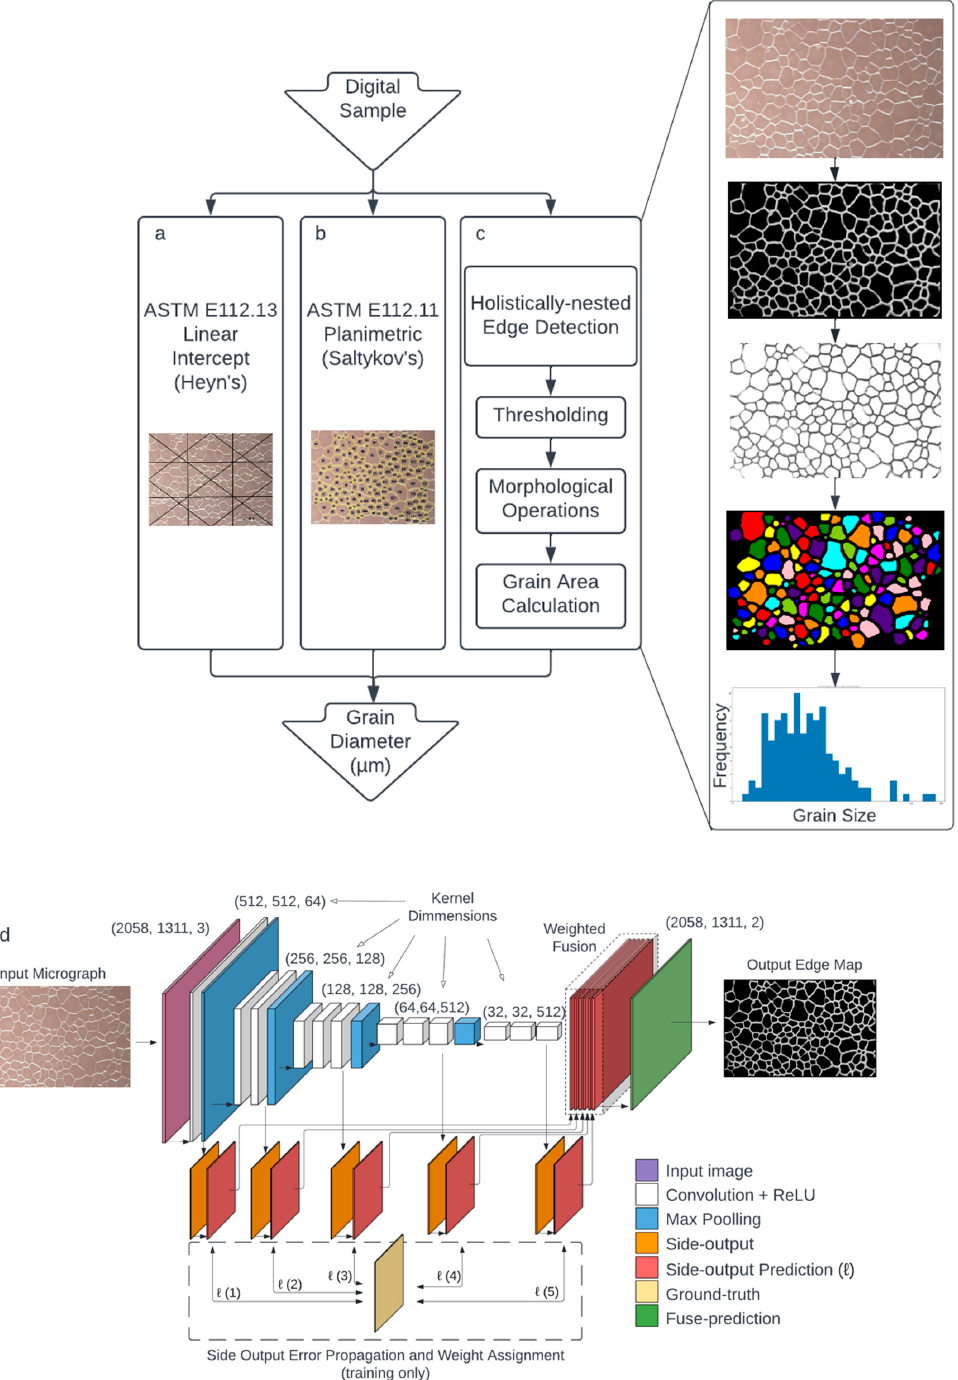
Figure 1. Workflow for methods of determining mean grain diameter from an optical micrograph, including Heyn’s ( a ), Saltykov’s ( b ), and the newly proposed method ( c ). The HED architecture ( d ) follows a VGGNet-inspired convolution and pooling structure but extracts the side output of each last convolutional layer to which predictions are made and compared to the ground truth image. The model composes five stages with strides 1, 2, 4, 8, and 16, each with its own side output. Weights are then assigned to each side-output prediction and combined into a final loss function to create a fuse prediction. The finalized output is a grayscale edge-prediction map with the same height and width as the original image. The intensity of each pixel is associated with the probability that the pixel represents an